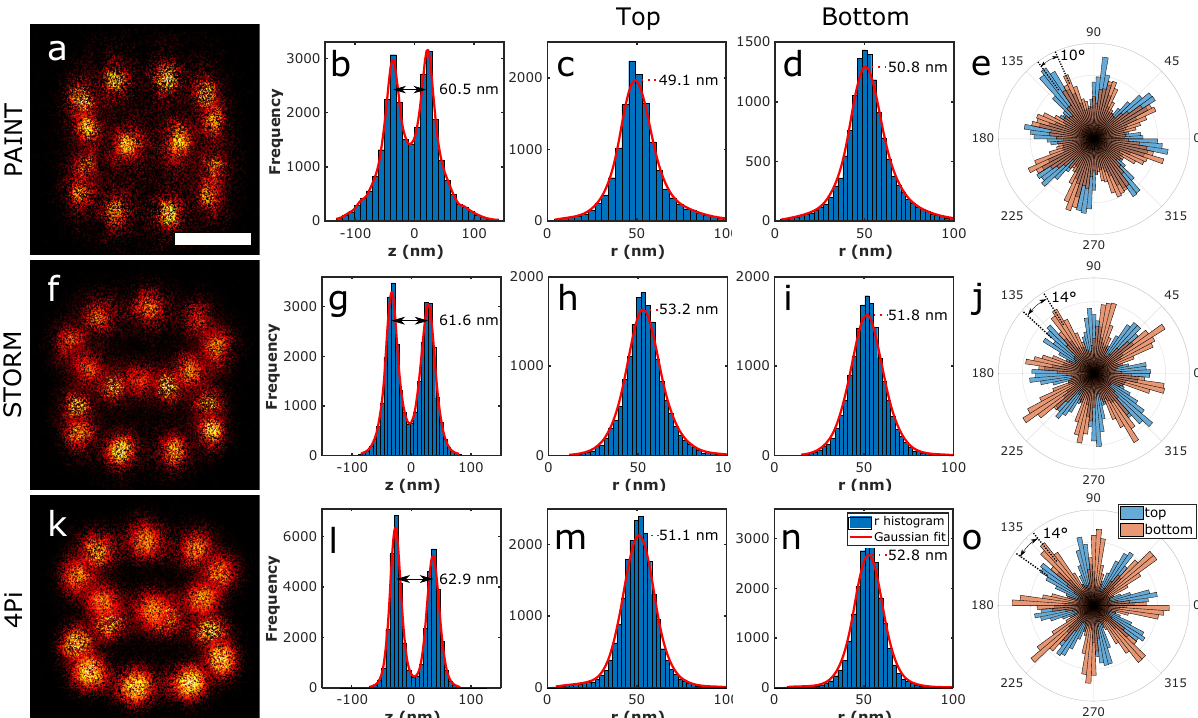
Fig. 2 3D Particle fusion of Nup107 acquired with different 3D localization microscopy techniques. a Fusion of 306 particles acquire by 3D astigmatic PAINT. b Histogram of the Z coordinate of localizations in the super-particle. c Histogram of the radius of cytoplasmic ring localizations, d nuclear ring. e Rose plot of the localization distribution over azimuthal angles for the cytoplasmic (blue) and nuclear (orange) rings of the super-particle. f Fusion of 356 particles acquired by 3D astigmatic STORM. g – j Similar to b – e . k Fusion of 750 particles acquired by 4pi STORM. l – o Similar to b – e . Scale bar is 50